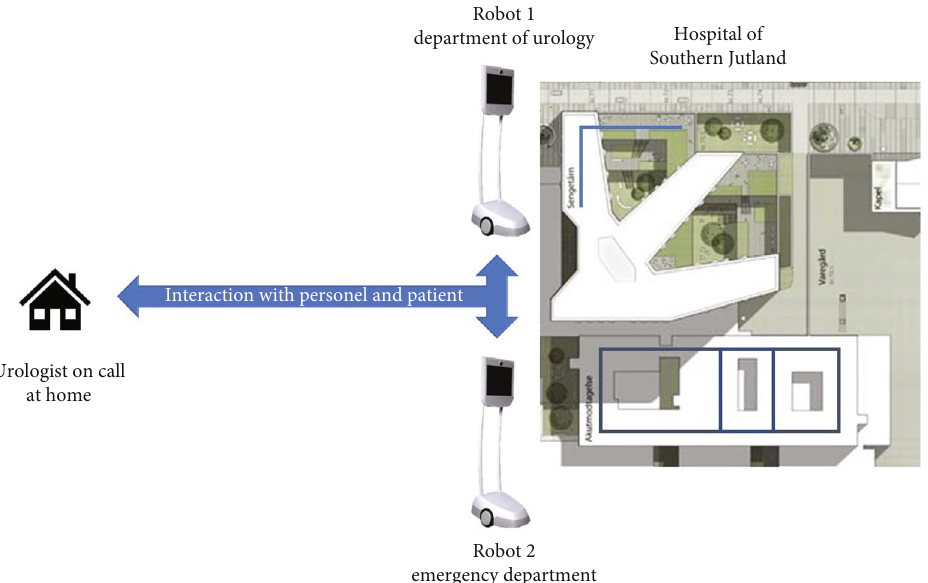
Figure 1: Geographical system architecture. Two di ff erent telepresence robots were used in this study: one located at the urology ward and one located at the emergency